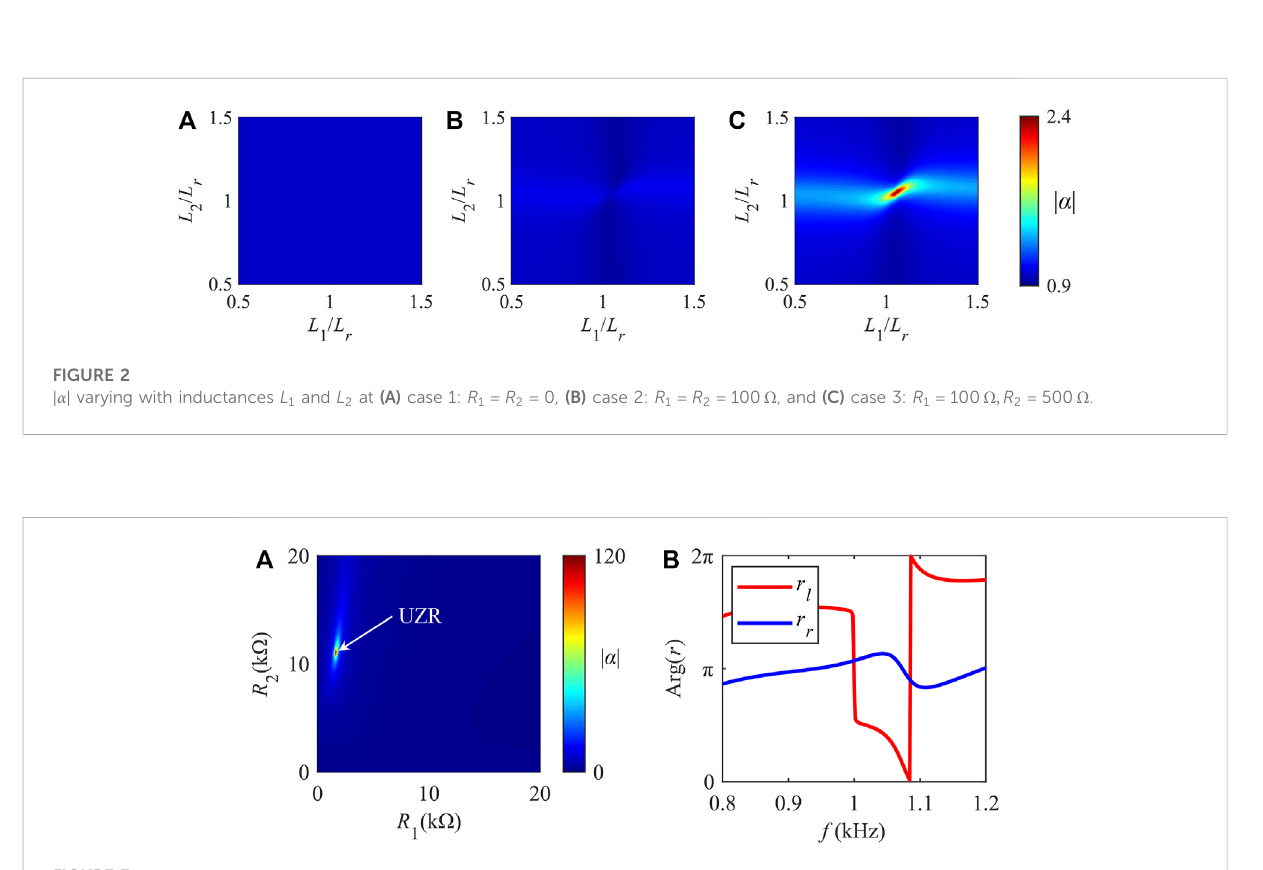
R (B) Phases of re fl ection coef fi 1 and 2 .